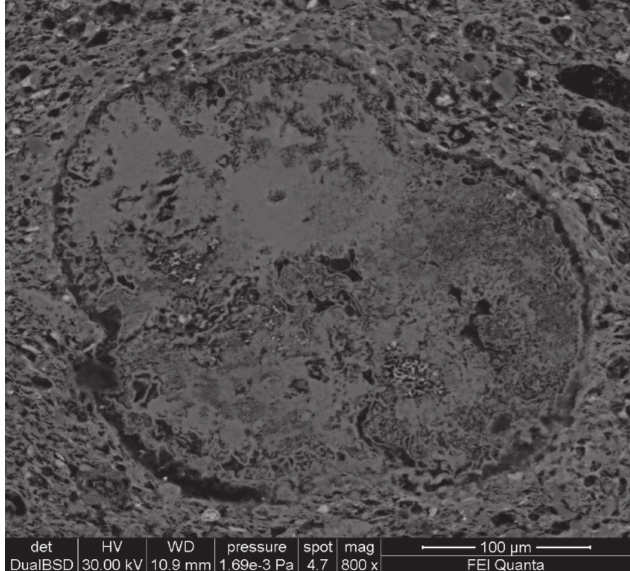
Figure 4. BSE image of a Globigerinoides microfossil identified in sample 4032-103 (loner, Black-Gloss